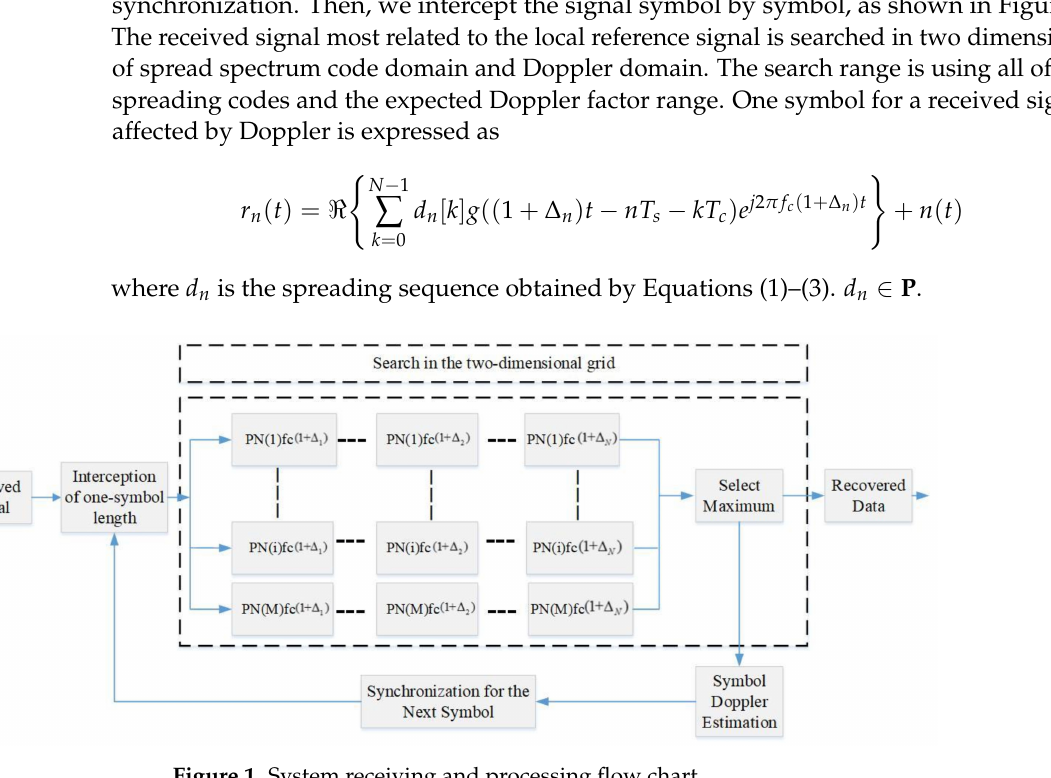
Figure 1. System receiving and processing flow